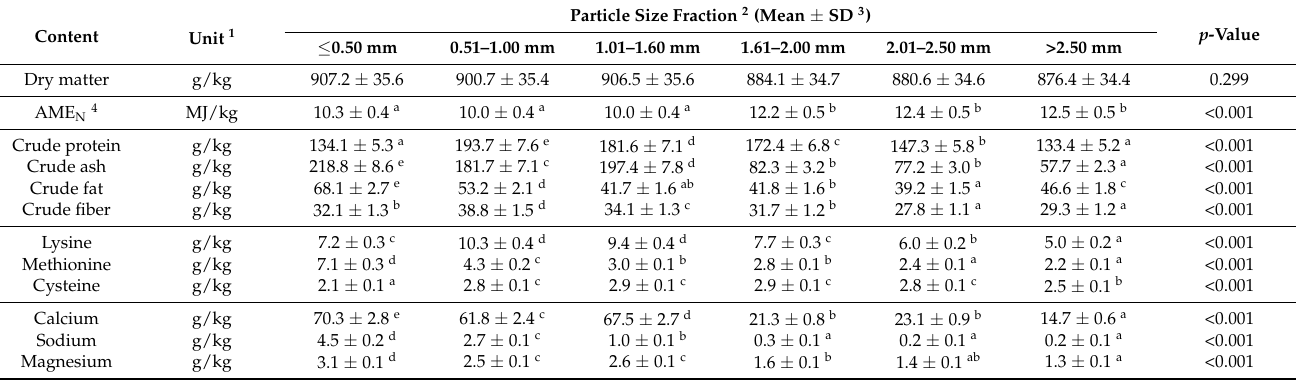
1 as feed. 2 different indices indicate significant differences. 3 mean—arithmetic mean, SD—standard deviation. 4 apparent metabolizable energy. n